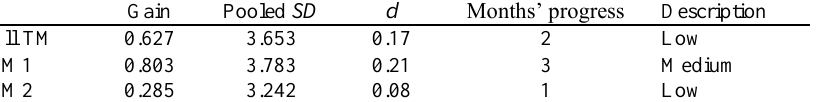
Table 6 Gains, pooled standard deviations and effect sizes ( d ) for the TM-classes as a whole and for TM1